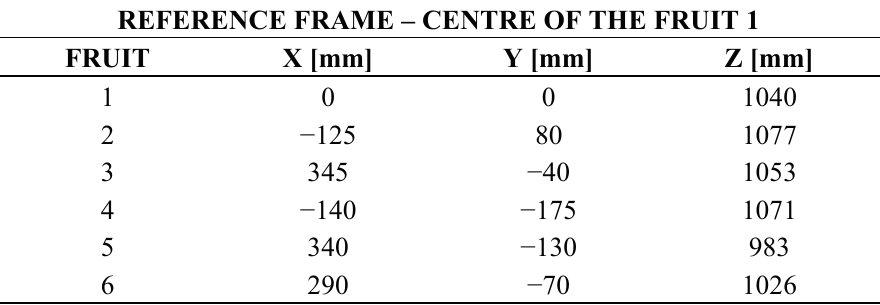
Table 1. Ground truth measurements for the scene presented in Figure